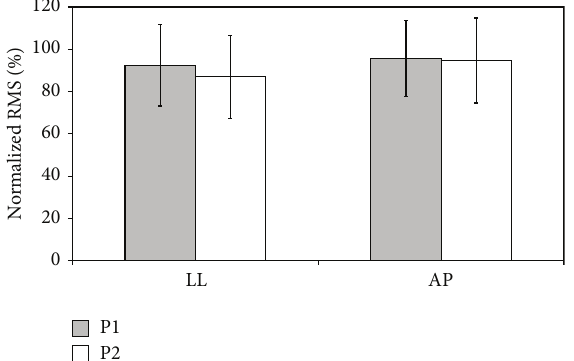
Figure 5: Root Mean Square (RMS) of acceleration along antero- posterior (AP) and laterolateral (LL) axes normalized with respect to those of craniocaudal (RMS-CC) by using the inverse of their percentage ratio in P1 and P2 (mean ±